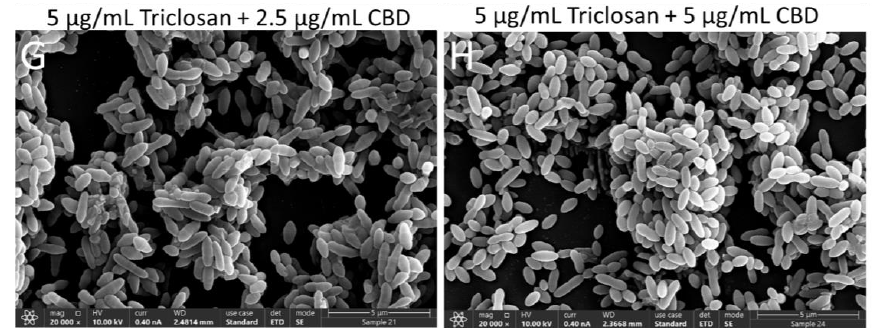
Figure 6. High-resolution scanning electron microscope (HR-SEM) images of planktonic growing S. mutans after a 2 h treatment with the indicated treatments ( A – H ). The blue arrows in ( A ) point to the classical ovococci form of S. mutans . The red arrows in ( D ) point to aberrantly shaped bacteria with multiple division septa. The green arrows point to extreme long bacteria. Uncropped images are presented in Supplementary Figure S3.